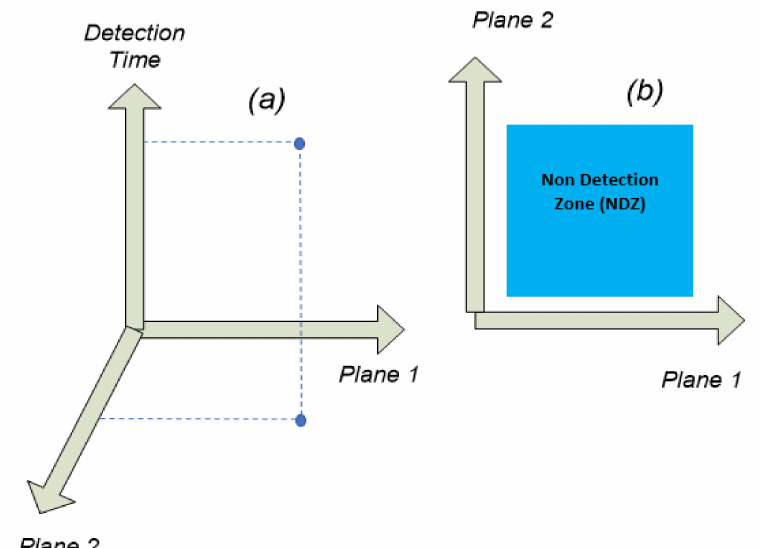
Figure 8. Power mismatch plane to illustrate the power imbalance and associated NDZ. ( a ) Detection time for a given power imbalance case and ( b ) Plane 1 versus Plane 2 to illustrate the NDZ